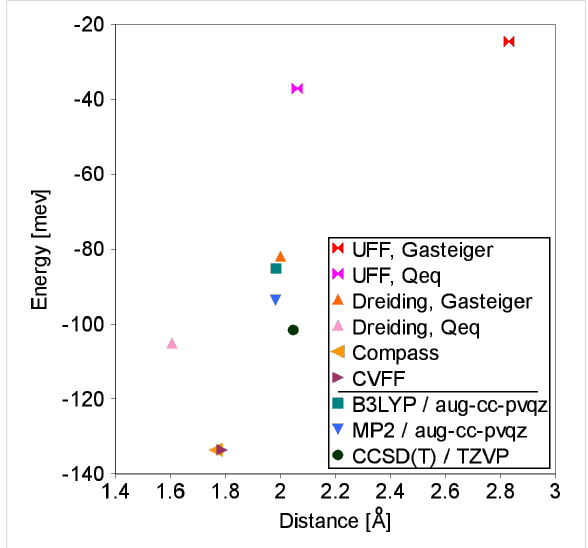
Figure 4: Equilibrium distance and interaction energy for water dimers, calculated with different force fields and with quantum chemical